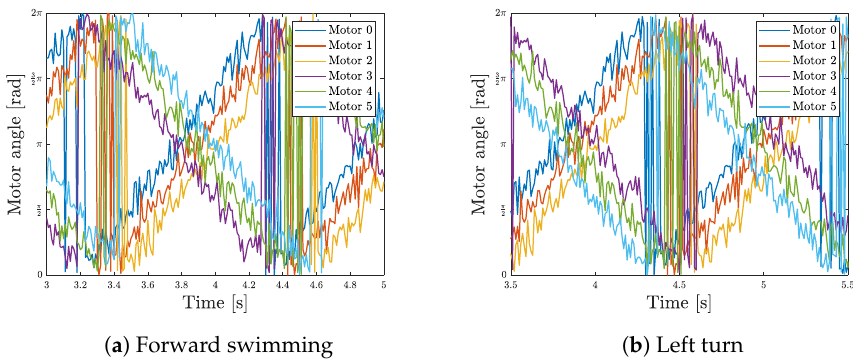
Figure 22. Encoder signals.